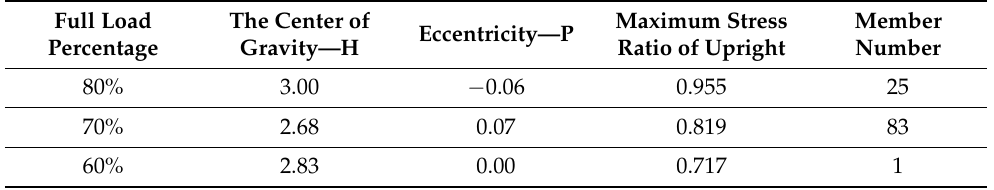
Table 6. Parameters related to the most favorable distribution patterns of the optimized loads.